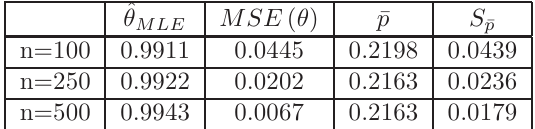
Simulations for Exponential AFT model, Exponential